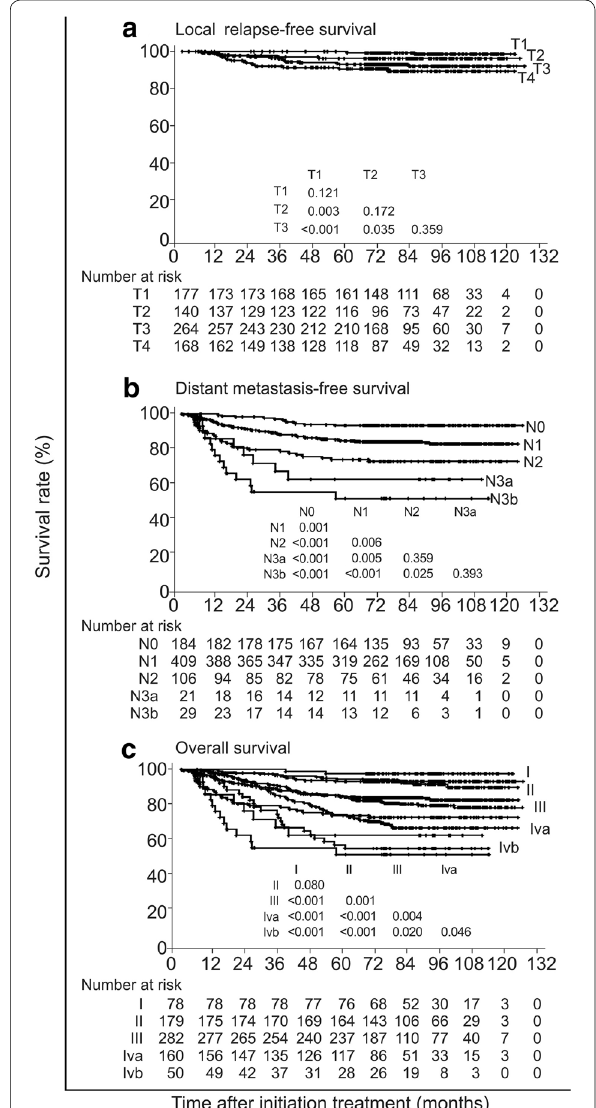
Fig. 2 Survival curves of 749 patients with NPC who were treated with IMRT. The current 7th edition of the Union for International Cancer Control/American Joint Committee on Cancer (UICC/AJCC) staging system was used for staging. a The 5‑year local relapse‑free survival (LRFS) rates for patients with stage T1‑T4 NPC were 98.4, 96.2, 93.0, and 90.5%, respectively. b The 5‑year distant metastasis‑free survival (DMFS) rates for patients with stage N0‑N3b NPC were 93.3, 84.2, 72.4, 61.9, and 50.7%, respectively. c the 5‑year overall survival (OS) rates for patients with stage I‑IVb NPC were 97.4, 93.8, 81.8, 69.7, and 54.0%,